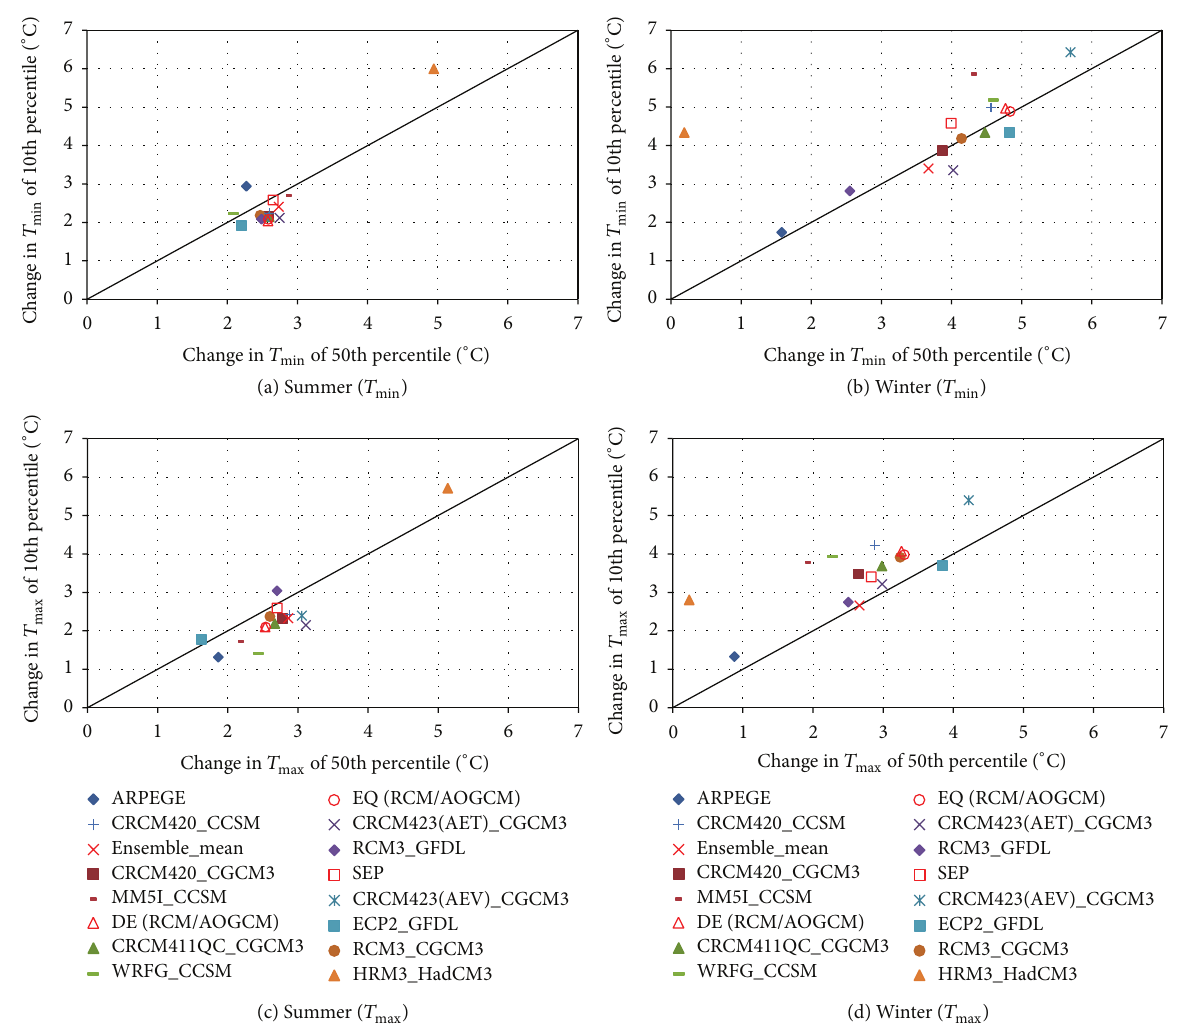
Figure 8: Same as Figure 7 but for the 50th ( 𝑥 -axis) and 10th ( 𝑦 -axis) percentile values of 𝑇 min and 𝑇 max